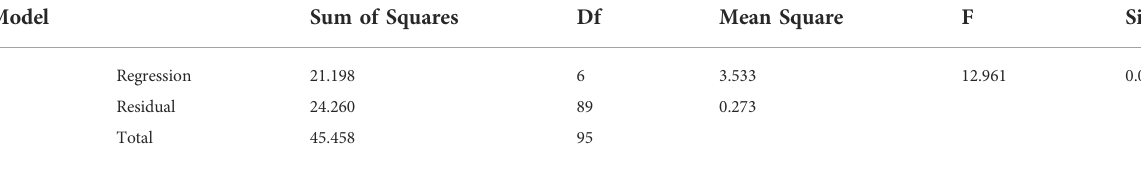
TABLE 13 ANOVA corresponding to the dependent variable for Pi.